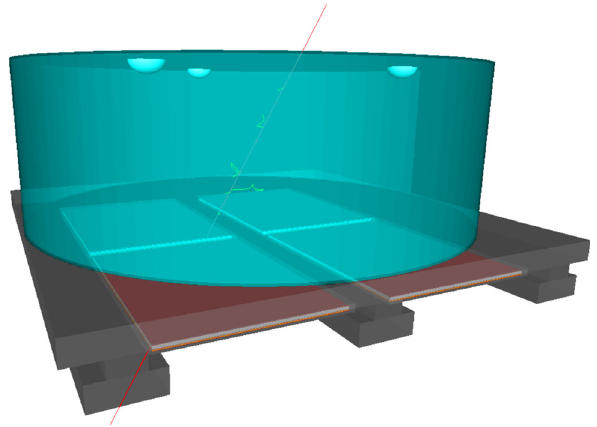
Fig. 1 TheMARTAimplementationforthePierreAugerObservatory: the RPCs (in brown) are placed under the water-Cherenkov detector (in green)whichprovidesactiveshieldingandtrigger.Theconcretesupport structure is shown in black